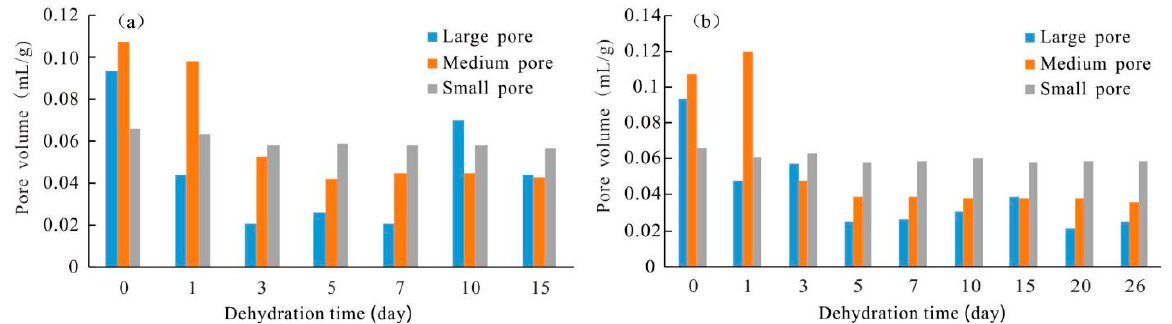
Figure 6. The volume of large, medium and small pores varies with the duration of dehydration under different environmental conditions ( a ) 50 °C-10%, ( b ) 50 °C-70%.